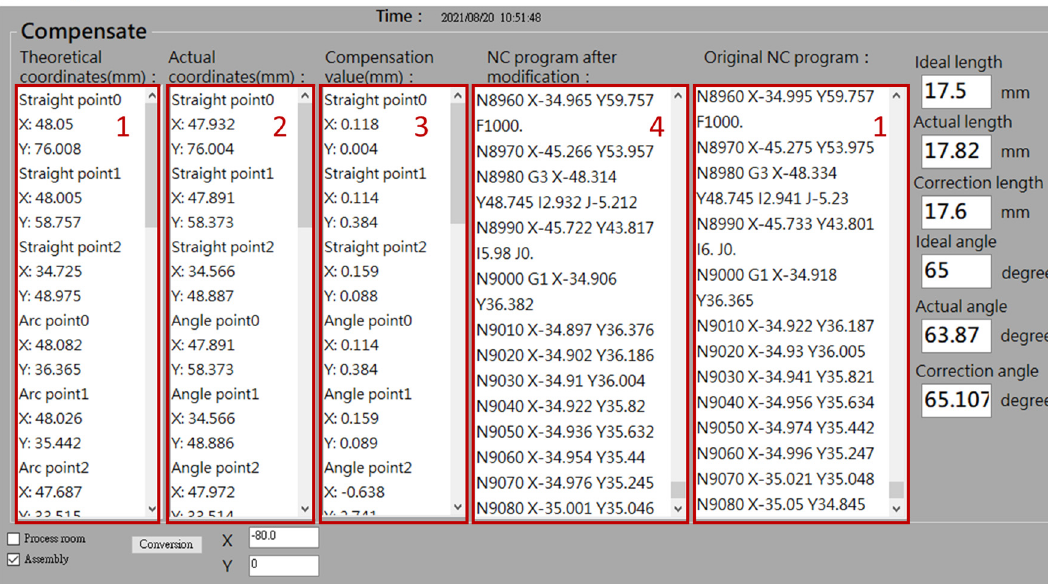
Table 1. Cutting parameters for experiment verification.